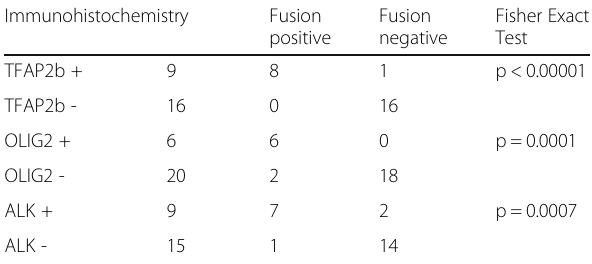
Table 3 Correlation between immunohistopathological reaction for TFAP2B, ALK and OLIG2 and PAX3/7-FOXO1 fusion status Immunohistochemistry Fusion